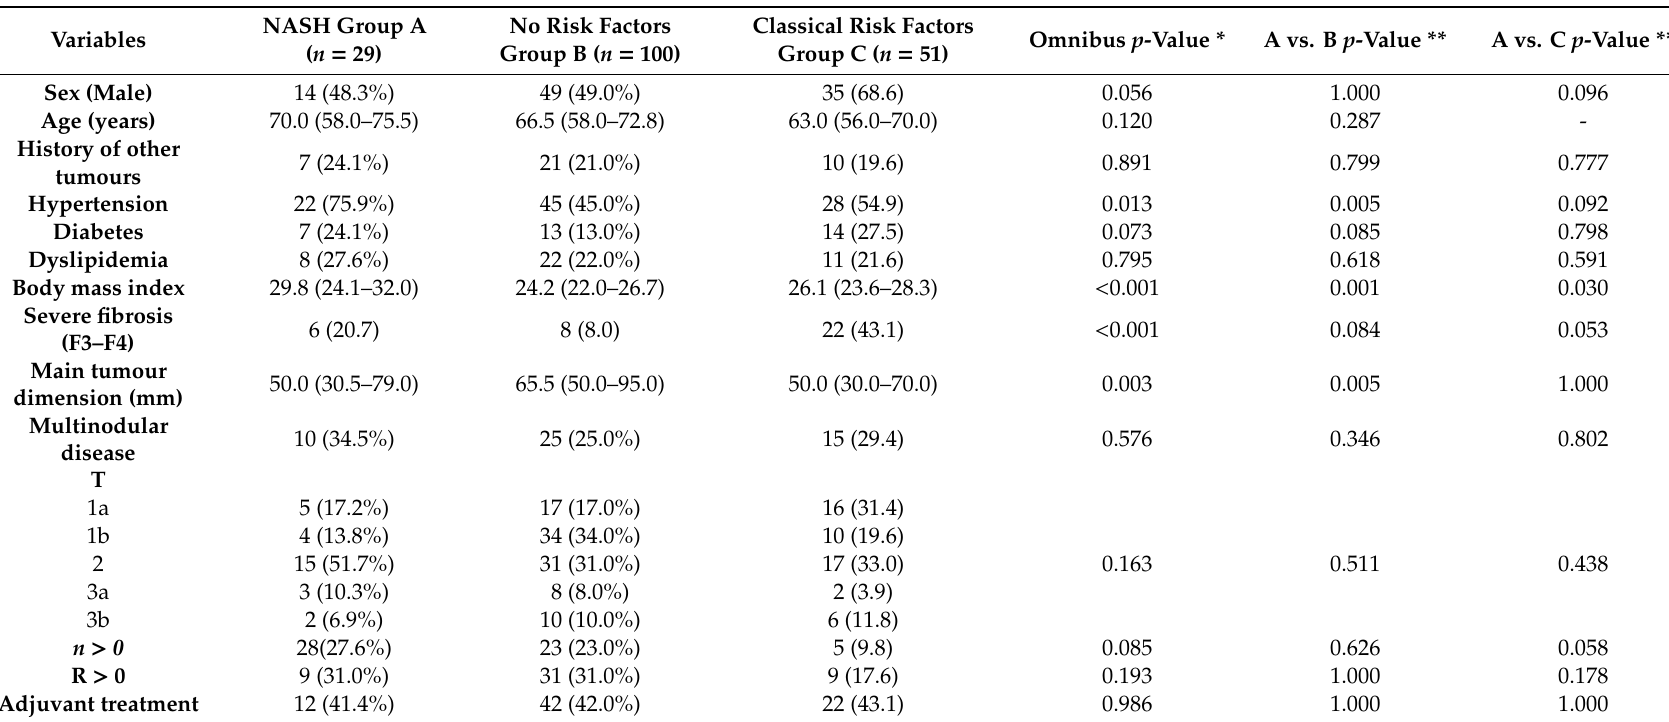
* Three-group comparisons were performed with the Kruskal–Wallis test for continuous variables and the Pearson Chi-square test for categorical variables. ** The Dunn-Bonferroni test and the Chi-square test for independence with a Bonferroni correction for multiple comparisons were used for the subsequent pairwise comparison of continuous and categorical variables,